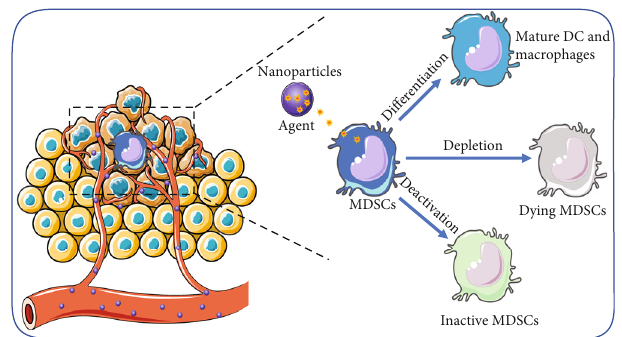
Figure 2: Nanomaterials for modulation of myeloid-derived suppressor cells (MDSCs). The immunotherapy strategy based on MDSC mainly includes the following three aspects: (i) induced to di ff erentiate into mature DC and macrophages, (ii) depleted or blocked its ampli fi cation, and (iii) inhibited the immunosuppressive